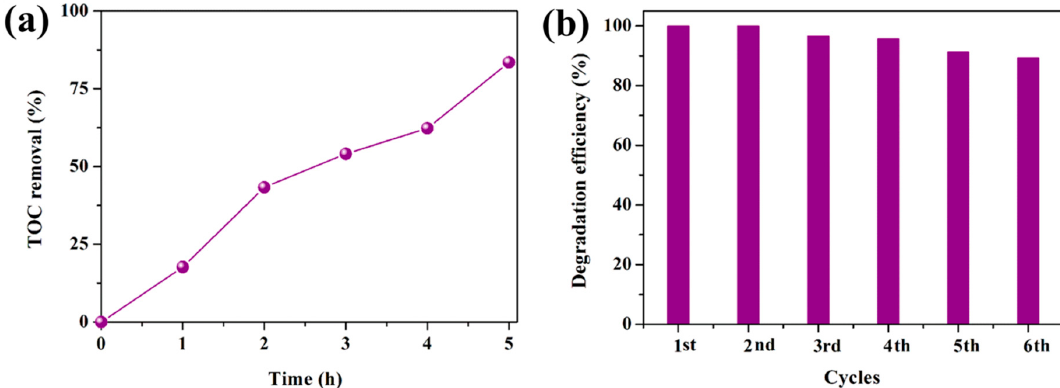
Figure 7. ( a ) TOC removal efficiencies over ACO/BOCH-100. ( b ) Cycling runs in the removal of RhB dye over ACO/BOCH-100.